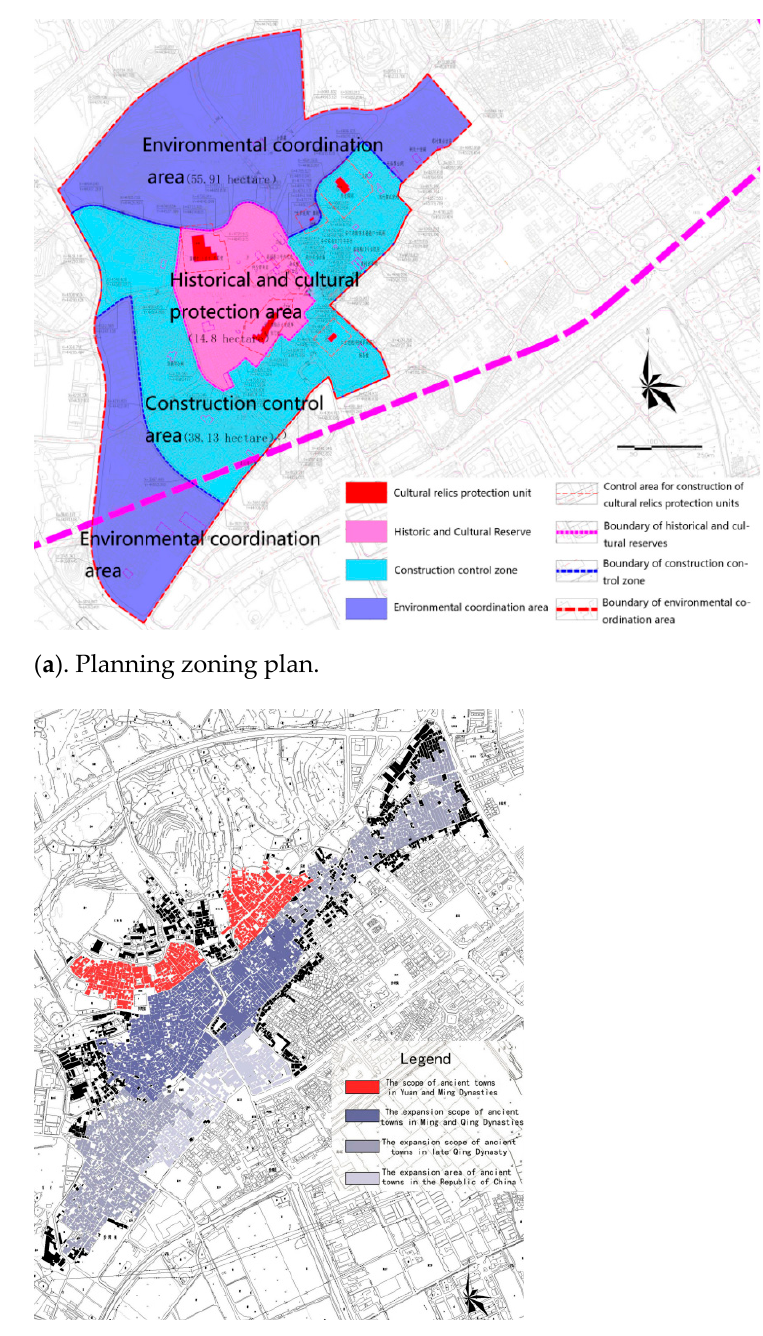
Figure 6. Field Analysis Diagram ( a ). Planning zoning plan. ( b ). Deductive Analysis of Ancient Towns.) (Source: [20]).